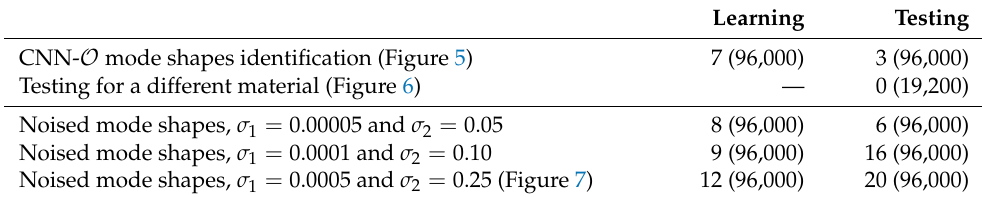
Table 2. Number of wrong CNN identification cases (among all considered cases).